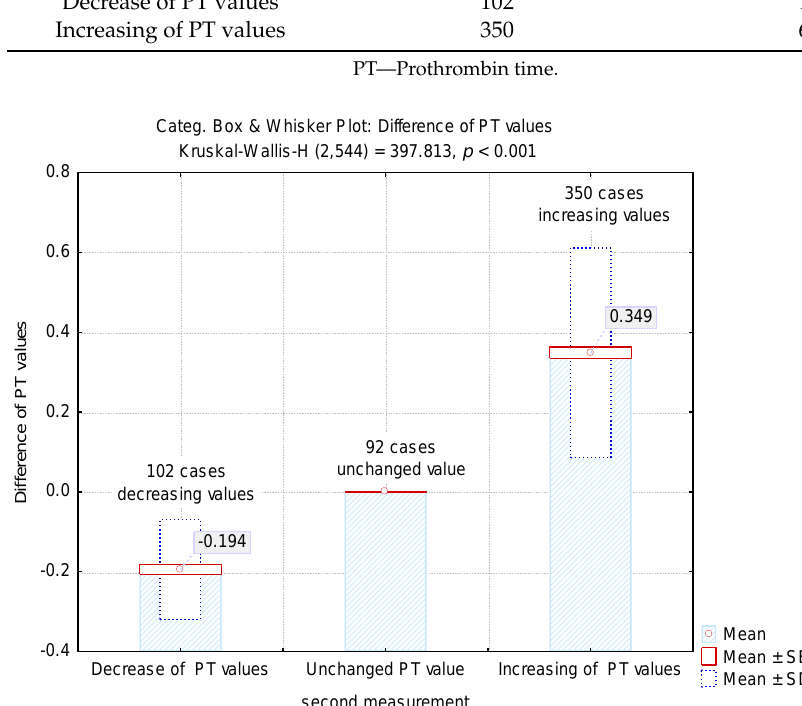
Figure 3. Mean values of the differences between the first and second determinations.